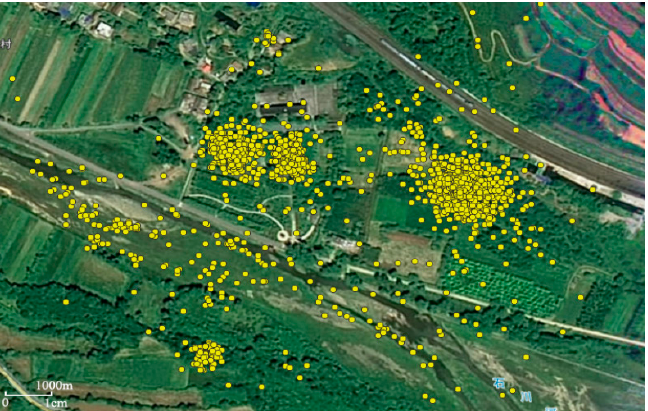
Figure 1. Distribution of latitude/longitude coordinates of crested ibis’s trajectory data. Each yellow point represents the crested ibis’s trajectory data at 1 h intervals from 2 January 2015 to 2 January 2016.